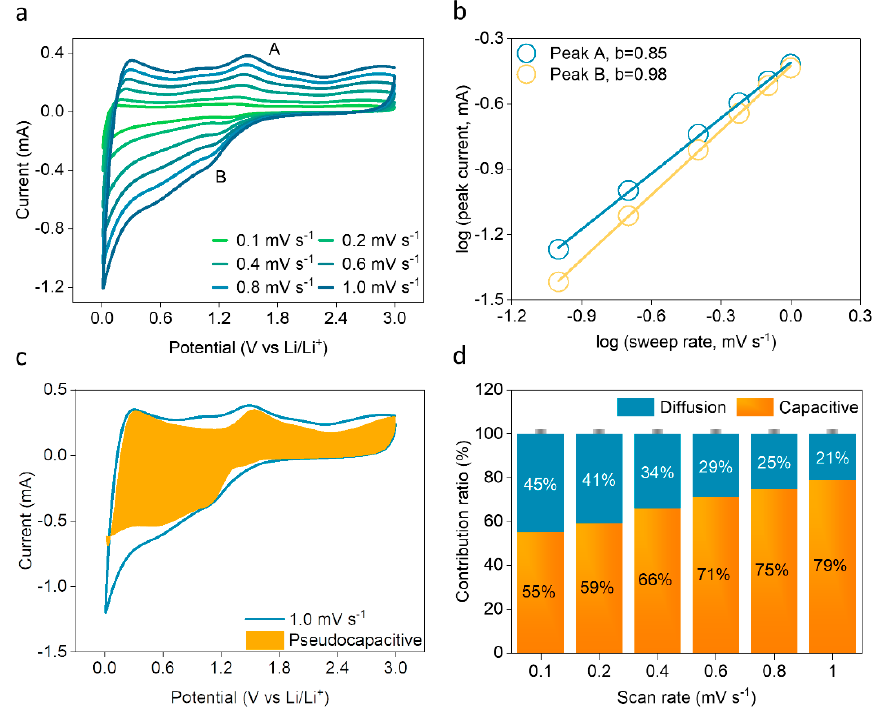
Figure 5. ( a ) CV pro fi les of TP − Ni with di ff erent scan rates. ( b ) Capacitance contribution for TP − Ni. ( c ) Relationship between the logarithm peak current and logarithm scan rates. ( d ) Contribution ratio of capacitive capacity at di ff erent scan rates.